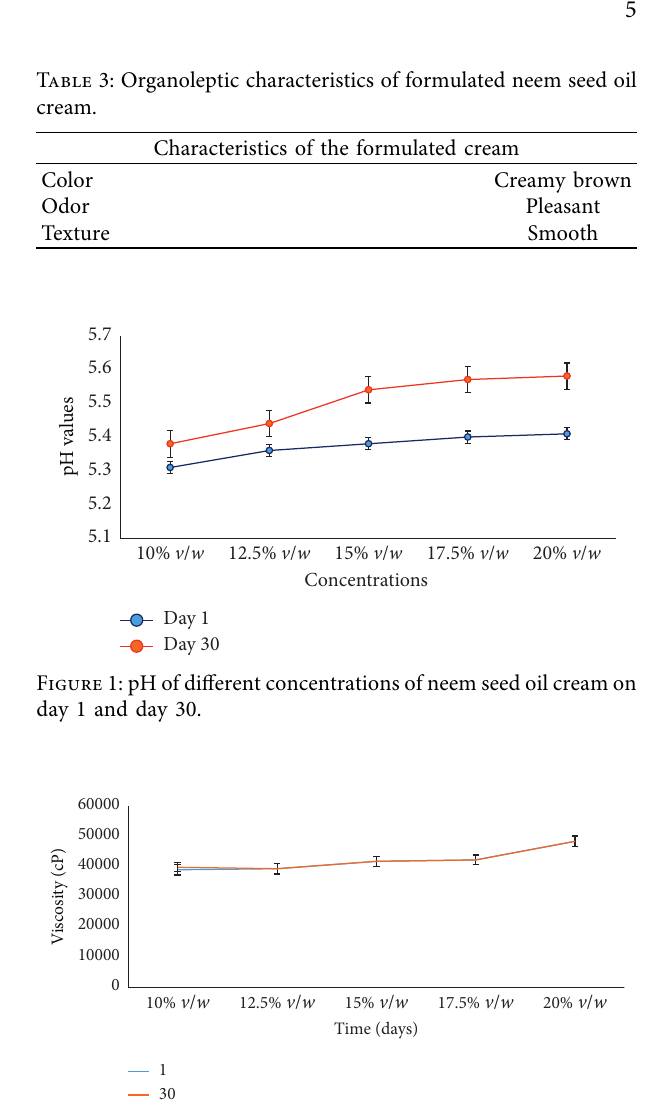
Figure 2: Viscosity studies of neem seed oil cream at their various